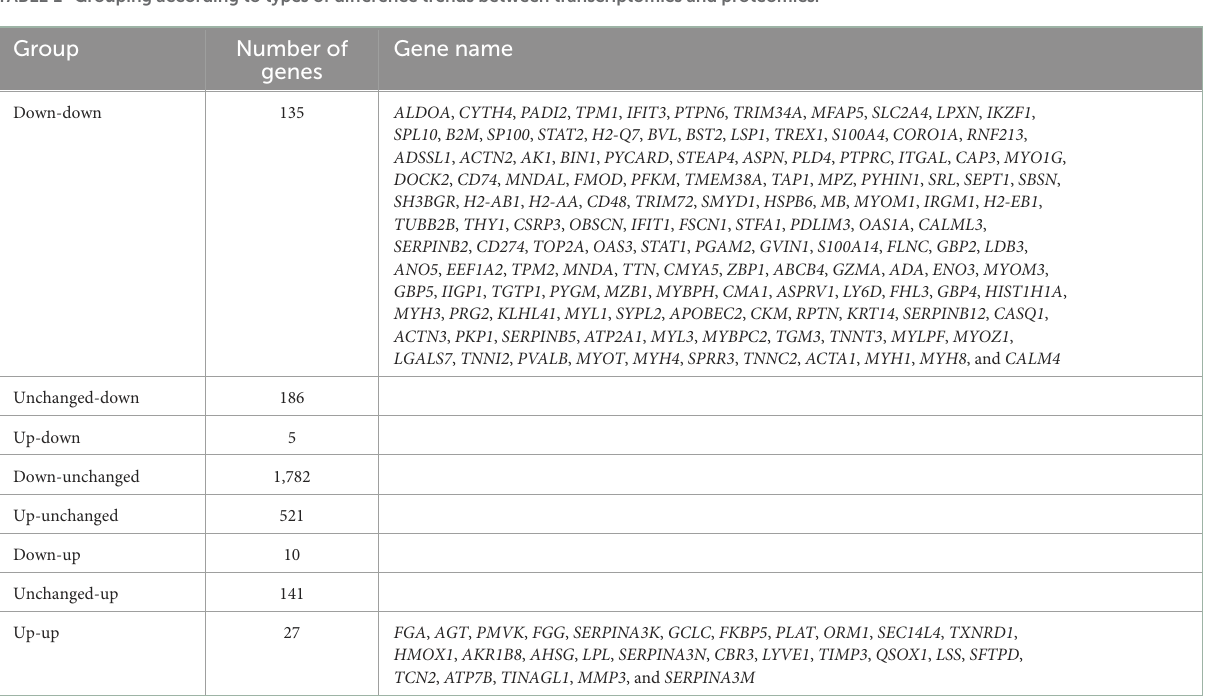
TABLE 1 Grouping according to types of difference trends between transcriptomics and